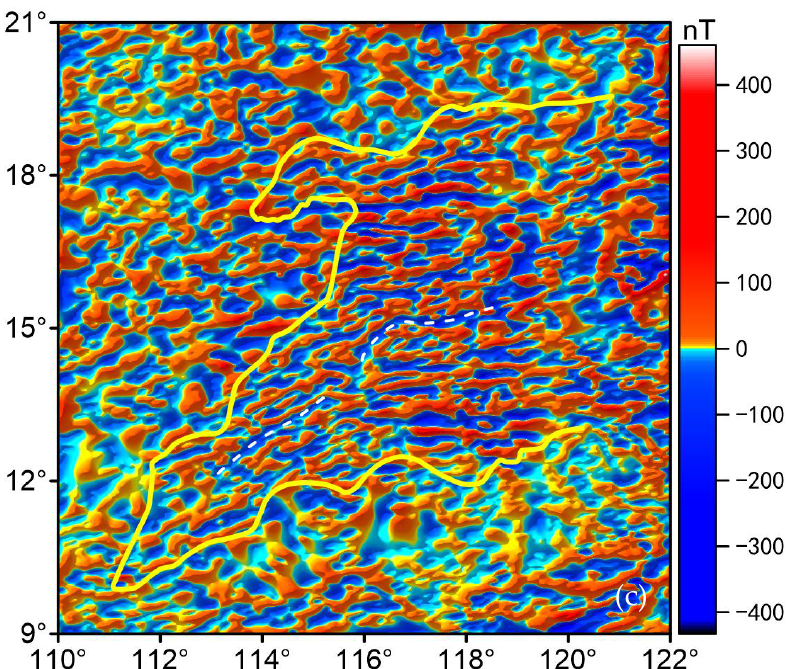
Figure 6. Separation results from the magnetic anomalies of the SCS. ( a ) The f a filtered magnetic anomalies. ( b ) The f b filtered magnetic anomalies ( c ) The separated spreading magnetic anomalies of the SCS by the nested elliptical directional filters. The solid yellow line denotes the continent – ocean boundary. The dashed white line denotes the position of the fossil spreading ridge.